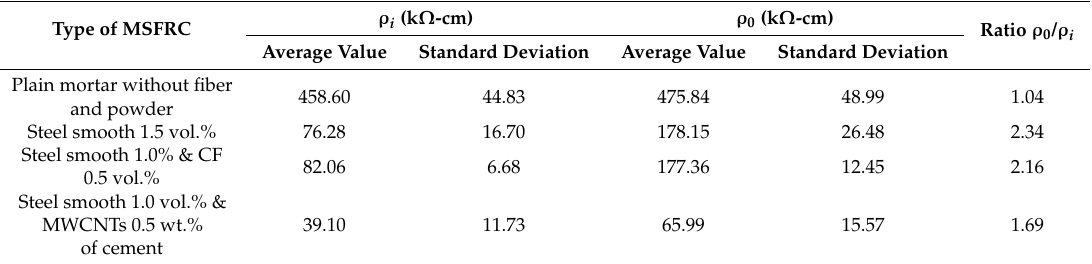
Table 4. Electrical resistivity of studied MSFRCs regarding various conductive additives.